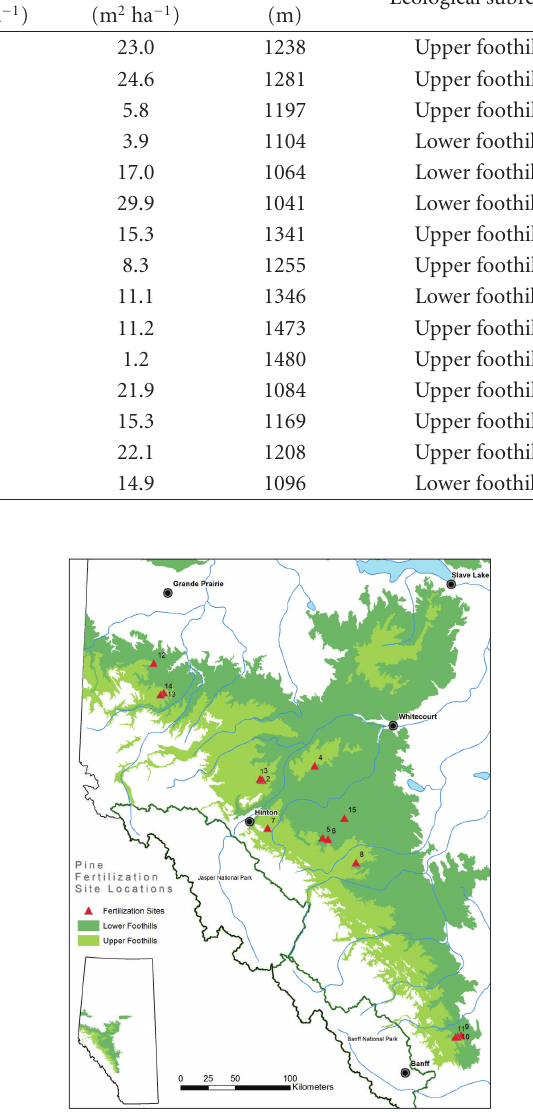
Figure 1: Map of the study region in the foothills of